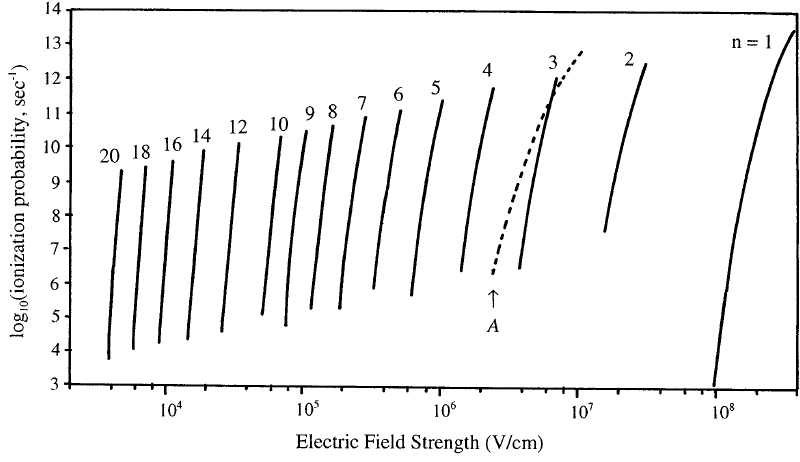
FIG. 1. Probability of Lorentz stripping for an H 2 ion and excited states of an H (cid:48) atom. “ (cid:110) ” is the principal quantum number of an H (cid:48) atom. “ (cid:65) ” indicates the probability of field dissociation for an H 2